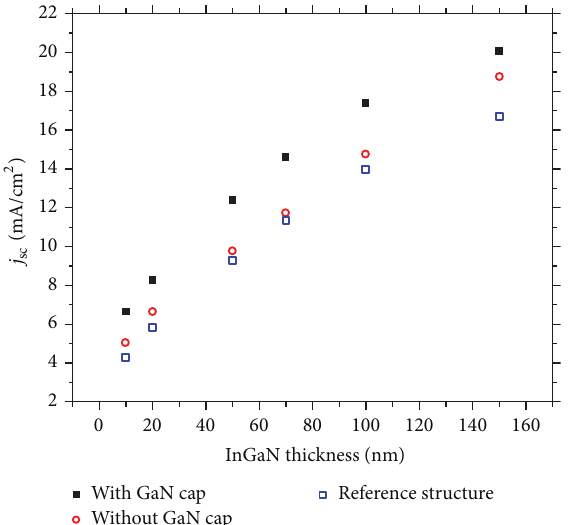
Figure6:Calculatedshort-circuitcurrentdensityversustheInGaNlayerthicknessdemonstratingtheimprovementasaresultofthestructure design incorporating the GaN cap layer. Comparison between the improved structure with the GaN cap layer in Figure 1(d), the initial structure without the GaN cap layer in Figure 1(c), and the reference structure shown in Figure 1(b).